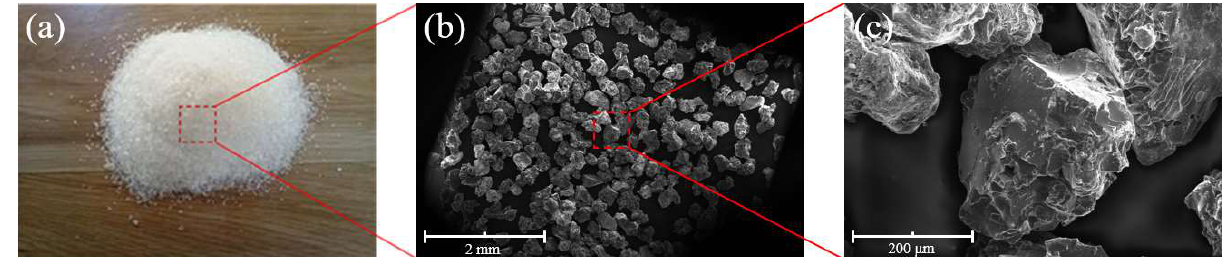
Table 1. Chemical composition of ASTM Type Ⅰ Portland cement.